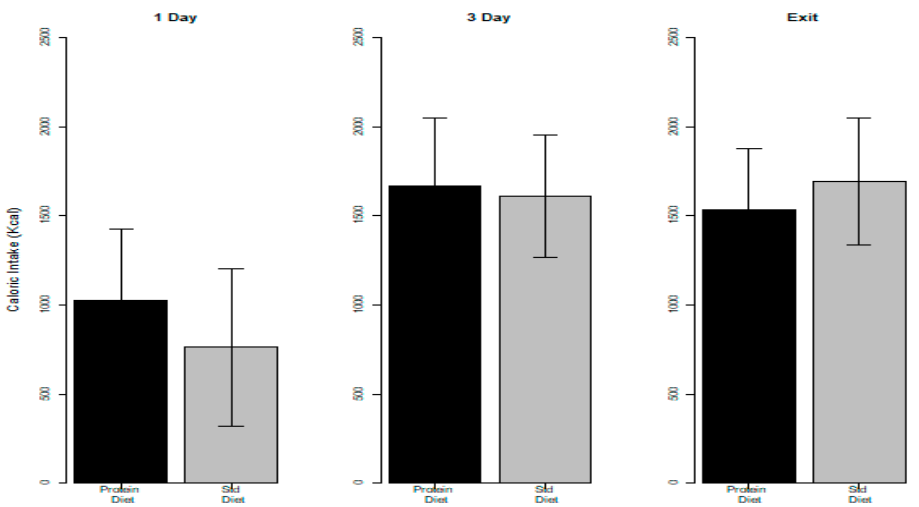
Figure 3. Energy (kcal) intake in the intervention and control groups on day 1, 3, and study exit.